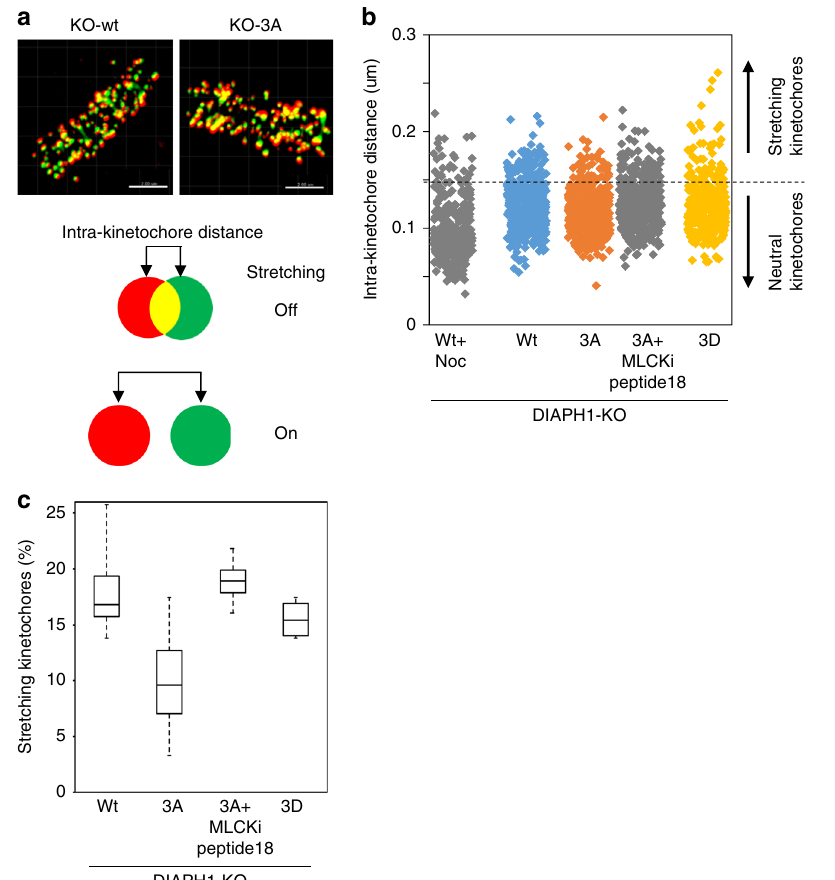
Fig. 6 Impaired kinetochore stretching in KO-3A cells. a Cells were stained for Hec1 (red, outer kinetochore marker) and CREST (green, inner kinetochore marker), and metaphase cells were analyzed. Projections of three-dimensional images are shown. Bar: 2 μ m. The intra-kinetochore distance is de fi ned as the distance between the centroid of red and green signals, and kinetochores with a distance above the threshold (see below) were referred to as stretched kinetochores. b The intra-kinetochore distances of nocodazole (160 ng/ml (531.6 nM))-treated Wt HeLa cells (Wt + Noc., n = 233 kinetochores from 5 cells), and KO-Wt, − 3A, − 3A + MLCKi peptide 18 (5 μ M) were plotted for 50 min, and KO-3D metaphase cells ( n = 318, 339, and 462 kinetochores from 4, 4, and 5 cells, respectively) were plotted as well. We determined the 95% con fi dence interval from the Wt + Noc experiment to be 0.156 μ m, which was set as the threshold for stretching (dotted line, Uchida et al. 33 ). c The rate of stretched kinetochores is shown in b . Box plots indicate median, interquartile values and